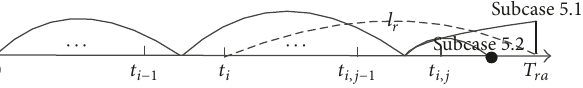
Figure 6: A delayed inspection replacement with a regular ordered